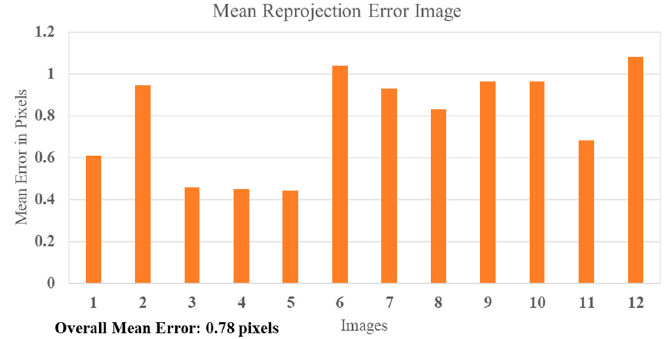
Figure 5. Result of mean reprojection error image. Table 2. Intrinsic parameter after optimization.